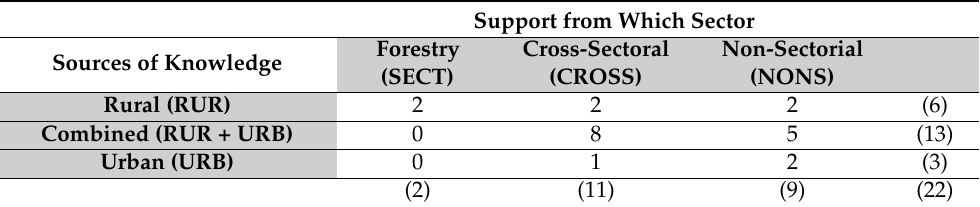
Table 2. Relations between sources of knowledge and sectoral support (remark: cases add up to 22 because two innovation cases received support from two different sectoral categories).